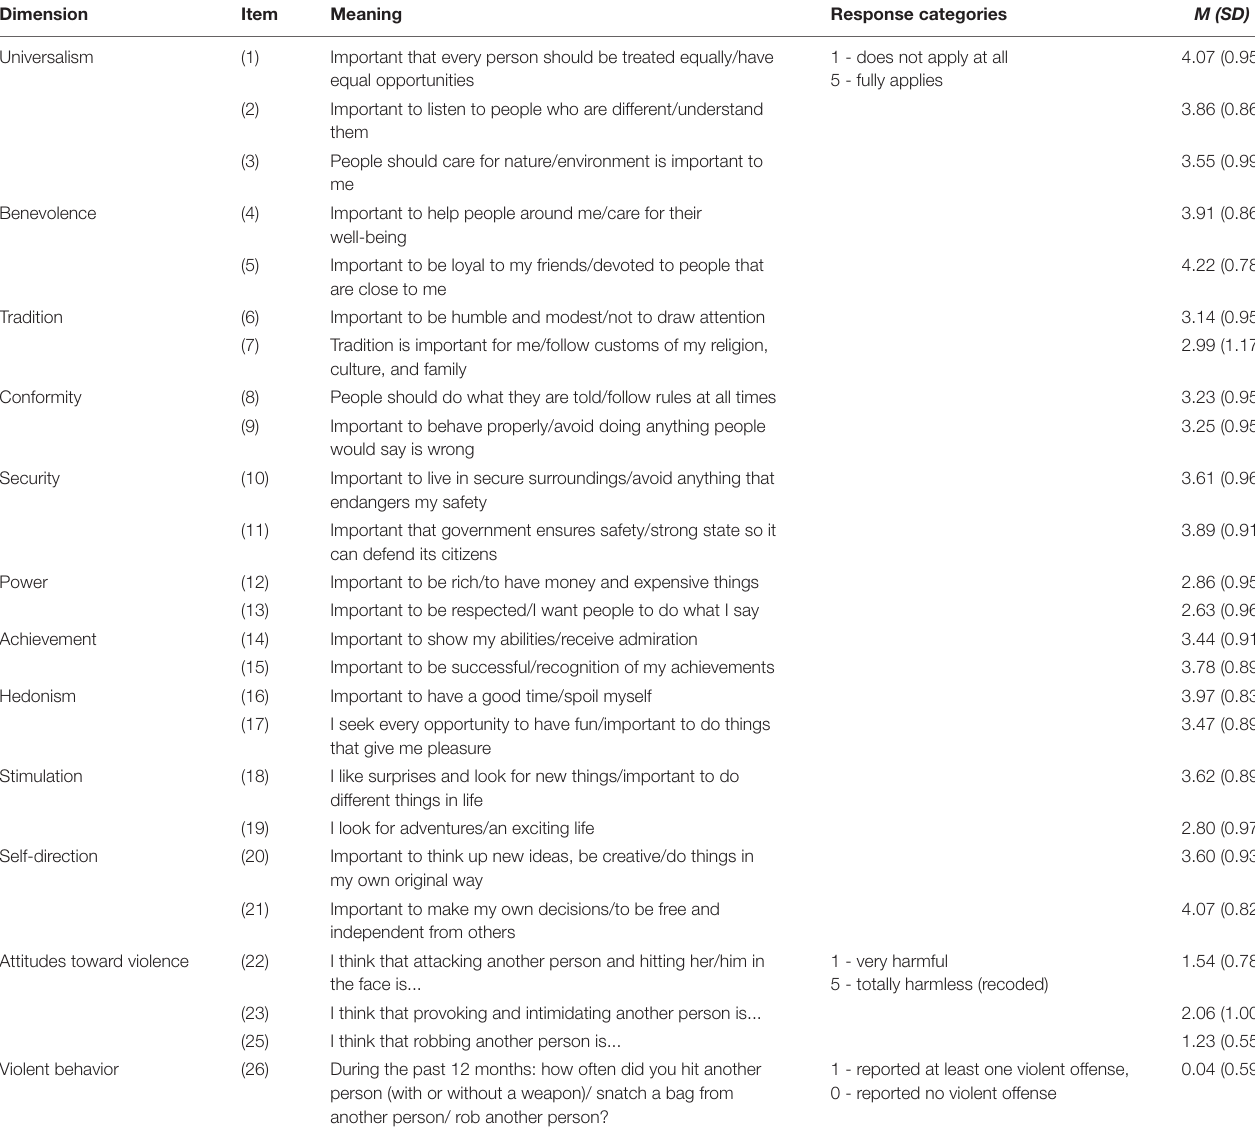
TABLE 1 | Items measuring values, attitudes, and behavior, and means (standard deviations in parentheses). Dimension